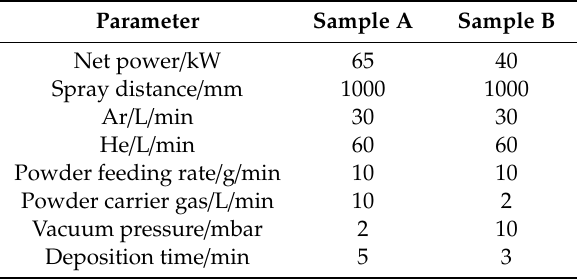
Table 3. Two di ff erent sets of spray process parameters. Table 2. Atmospheric plasma spraying (APS) process parameters.